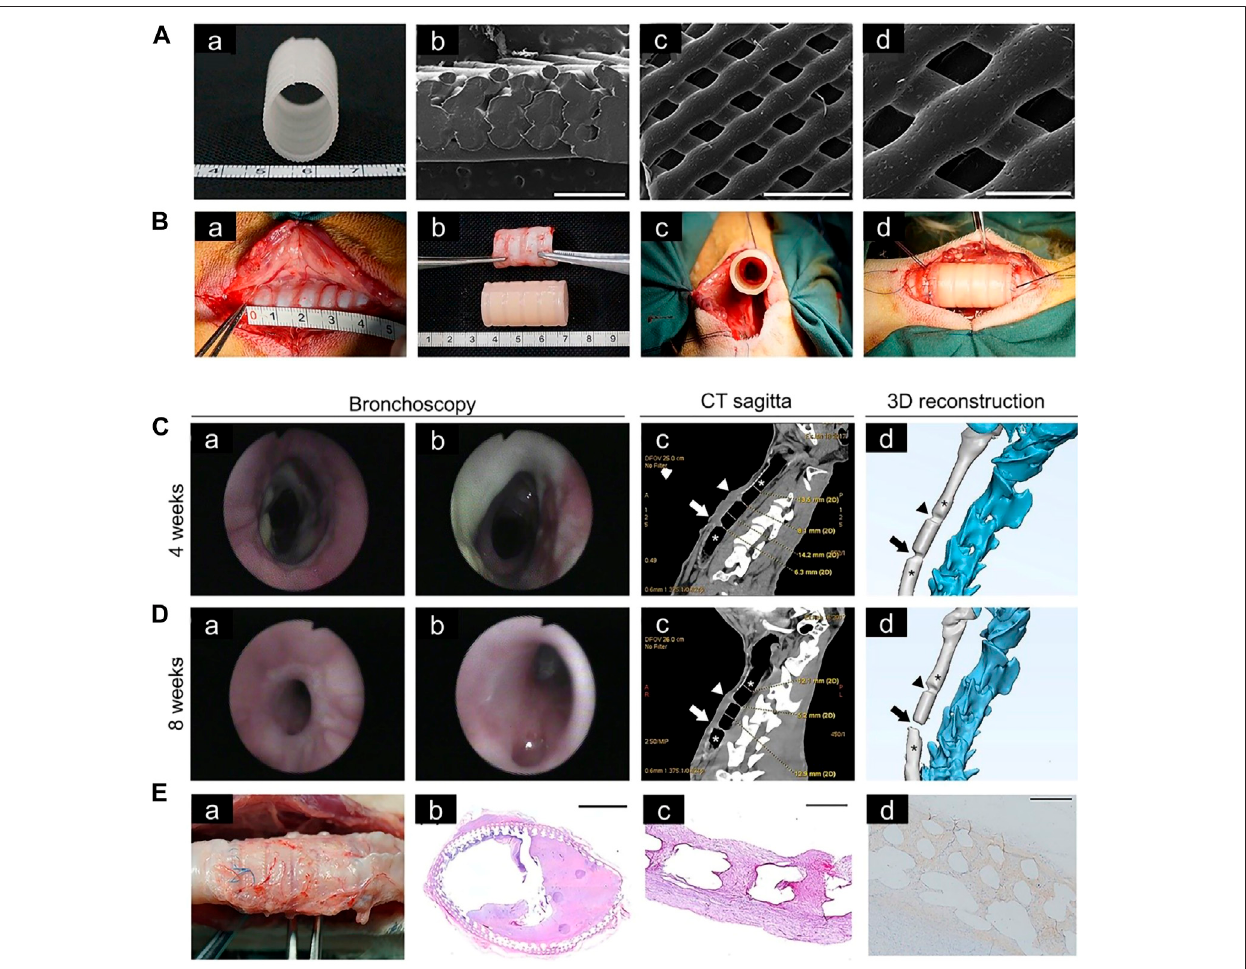
FIGURE 6 | Tracheal cartilage scaffolds were made by 3D printing technology and tested in vivo . (A) Macroscopic (a) and SEM (b – d) images of 3D-printed PCL scaffold. (B) Implantation of a tracheal cartilage scaffold. (C) Four weeks after implantation, tracheal images were acquired at the upper, middle and lower anastomosis sites, respectively (a,b) . Computed tomography (CT) sagittal images and representative sections of 3D-printing reconstruction after 4 weeks, in which the narrow area represents the upper and lower anastomoses (arrow) (c,d) . (D) Bronchoscopy images and CT sagittal images after 8 weeks. (E) The scaffold of the experimental group was removed at the time of death (a) . Hematoxylin and eosin staining of scaffolds at low magni fi cation (b) . Representative safranin O staining (c) . Representative collagen II staining (d) (Xia et al., 2019).